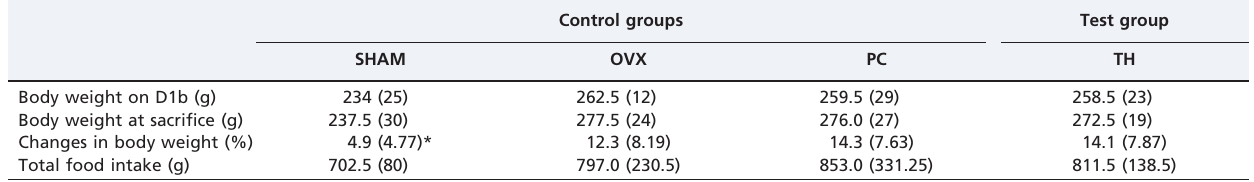
Table 3 - Effects of Tualang honey on body weight and food intake during six-week administration.